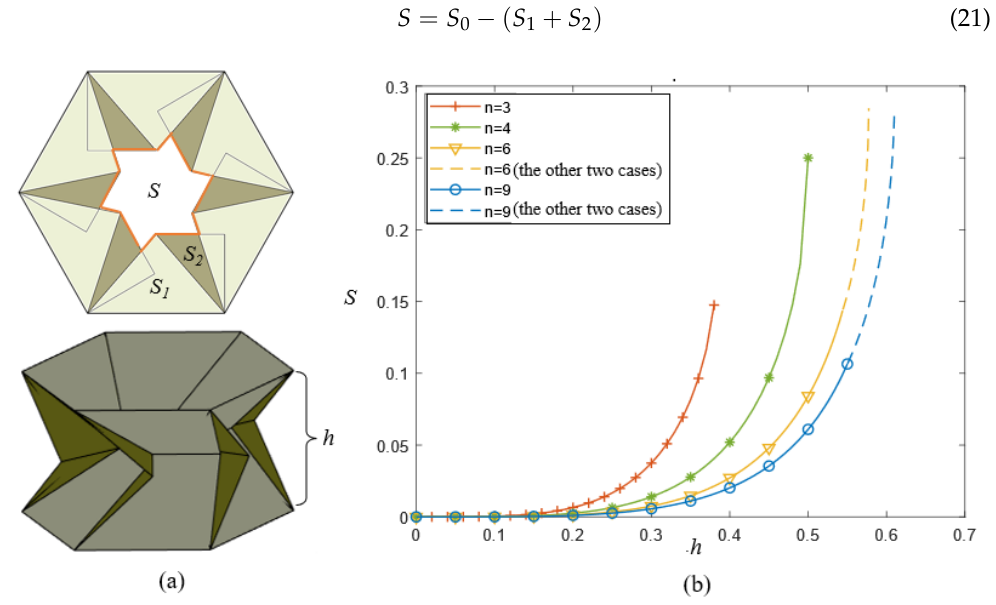
Figure 13. ( a ) Half-folded state of the RC-ori structure (kirigami counterpart). ( b ) The relationship between unfolded length and cross-section area. ( n = 6).